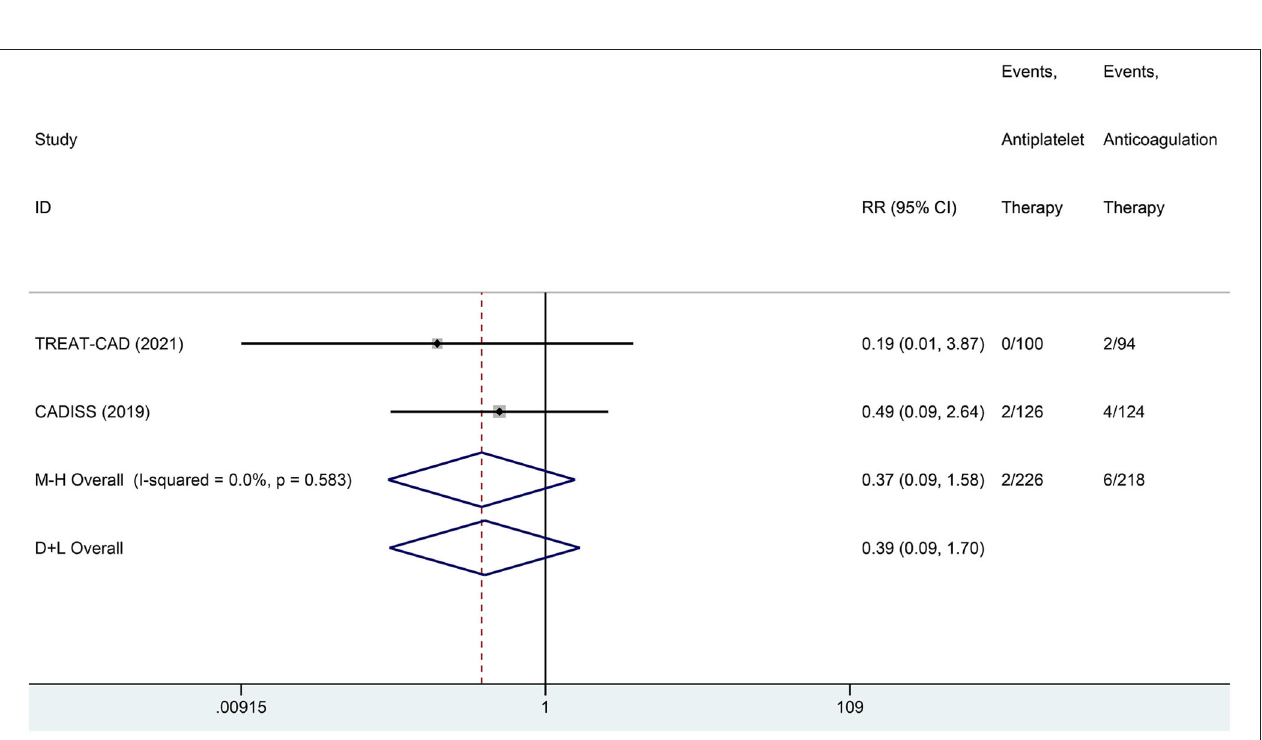
FIGURE 4 | A forest plot of comparison for transient ischemic attack (TIA) between the antiplatelet and anticoagulation in the ITT population.